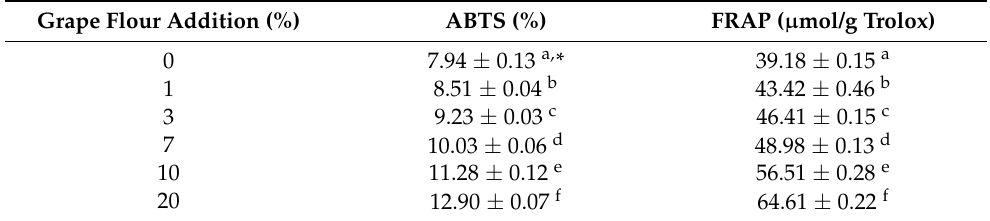
Table 1. Antioxidant capacity of vegetarian sausages measured by ABTS and FRAP methods. Grape Flour Addition